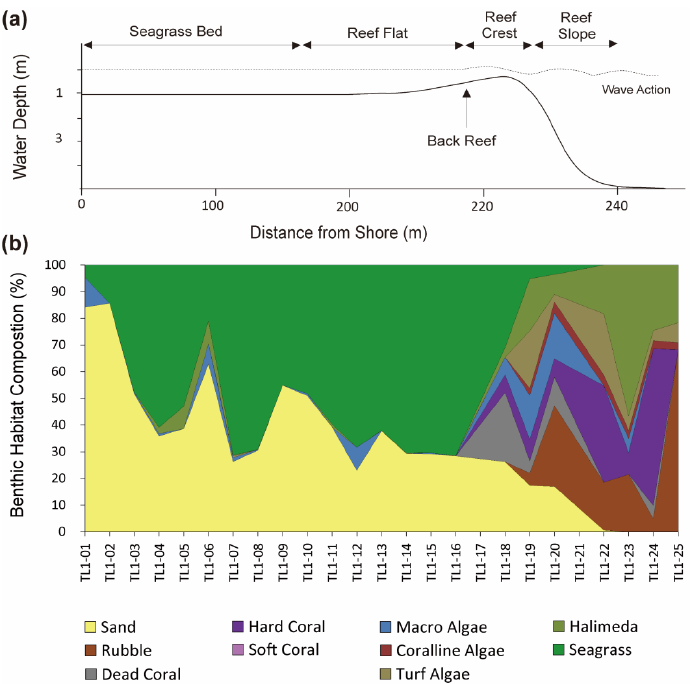
Figure 5. Benthic habitat evaluation results for the first transect line (TL-1). ( a ) Depth profile and topographical zonation from the shoreline to the reef edge. ( b ) Benthic habitat composition of the 25 sampling points (i.e., photo-quadrats) along TL-1.